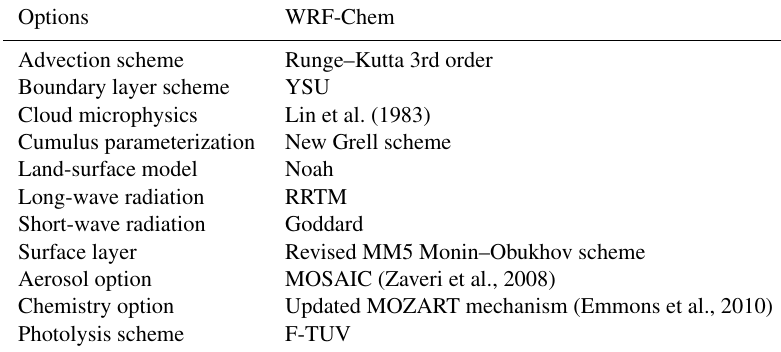
Table 1. Physical and chemical options in WRF-Chem used in this